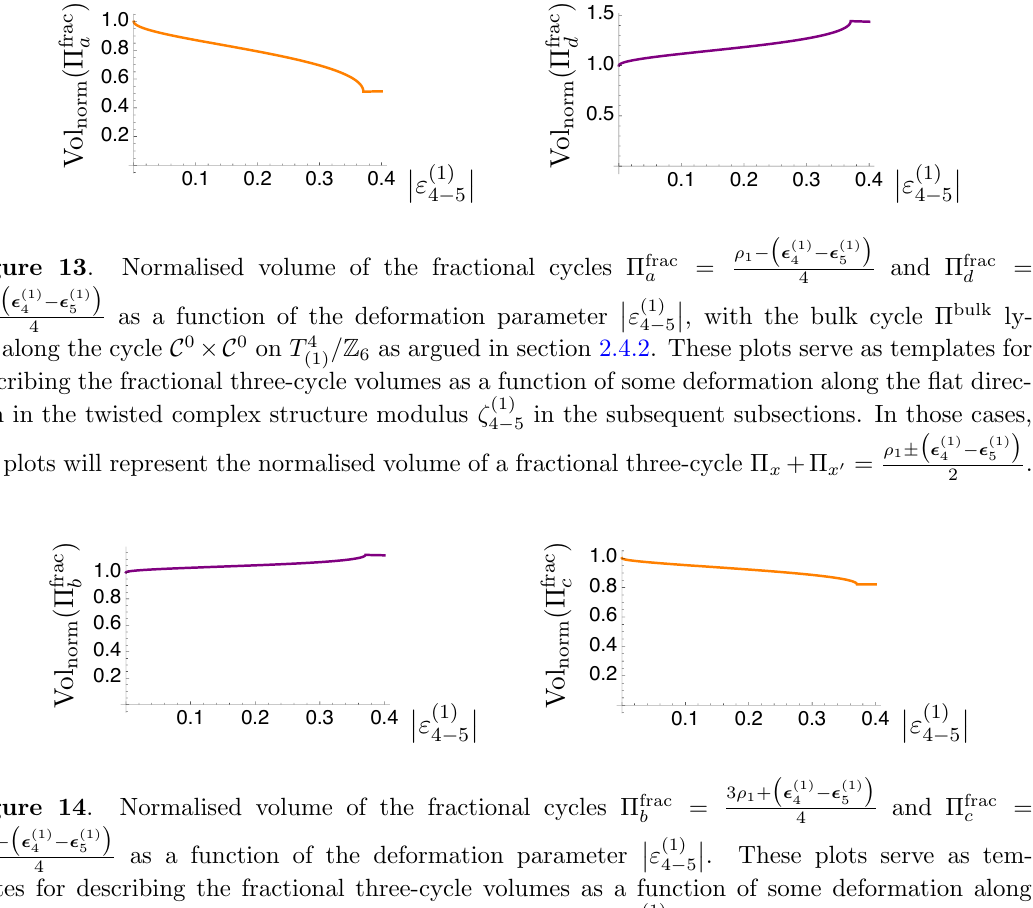
Figure 14 . Normalised volume of the fractional cycles (cid:5) frac (cid:0) (cid:1) 3 (cid:26) 1 (cid:0) (cid:15) (1) 4 (cid:0) (cid:15) (1) 5 as a function of the deformation parameter 4 plates for describing the fractional three-cycle volumes as a function of some deformation along the (cid:13)at direction in the twisted complex structure modulus (cid:16) (1) tions. In those cases, the plots will represent the normalised volume of a fractional three-cycle